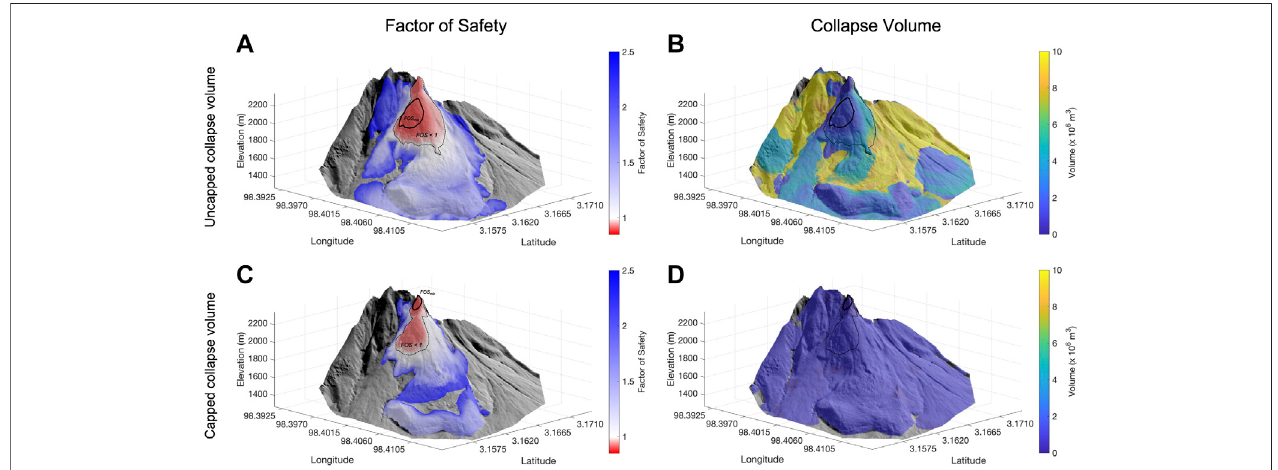
FIGURE 8 | Slope stability analysis results for the 2018 topography. Output from the Scoops3D model shows the FOS for the least stable failure region (A,C) and the volume of that failure (B,D) for each DEM cell. Erupted lava at Sinabung remains potentially unstable when applying the 2018 DEM and “ weaker lava ” material properties (A) . The potential failure volume (B) for the full search range is smaller than that for the 2014 DEM ( Figure 6B ). For potential collapse volumes restricted to 10 5 – 10 6 m 3 , the FOS min moves upslope to the scarp remaining from previous collapses (C,D) . The black outline in all panels marks the extent of the FOS min collapse, the dashed black line encloses areas with FOS < 1.